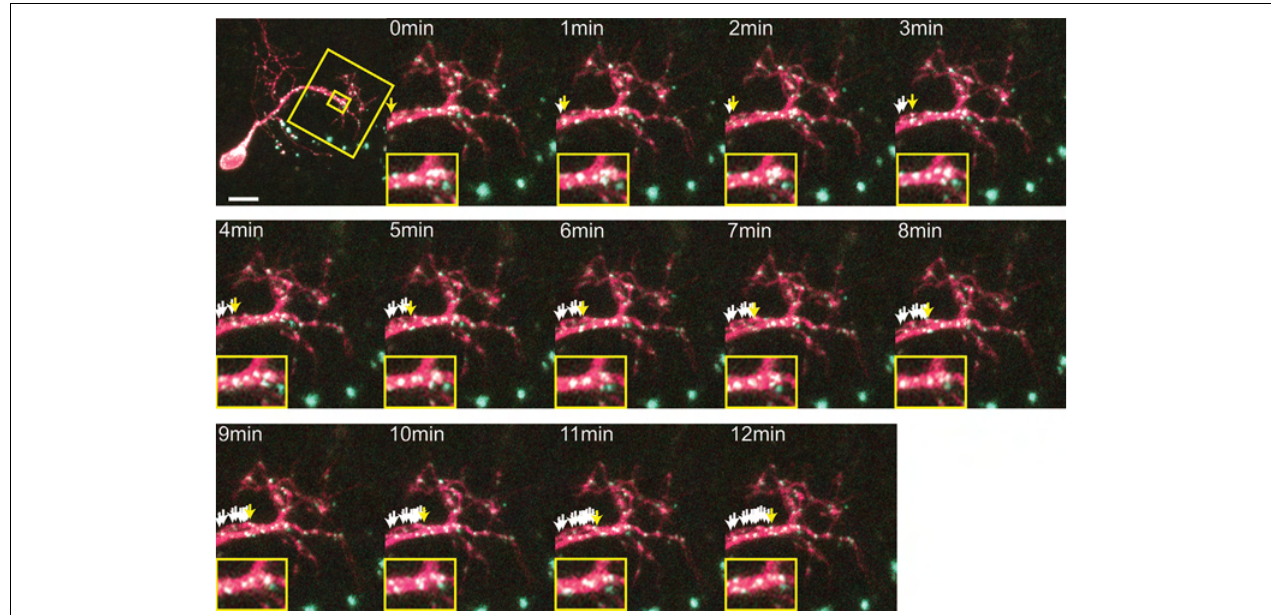
FIGURE 2 | Time-lapse of CPEB–CFP/YFP expressing tectal neuron. One minute interval time-lapse frames made of the dendrites of the CPEB–CFP/YFP-expressing cell in Figure 1A . The time-lapse series focuses on the boxed area of the dendrites. Arrows indicate the progressive history